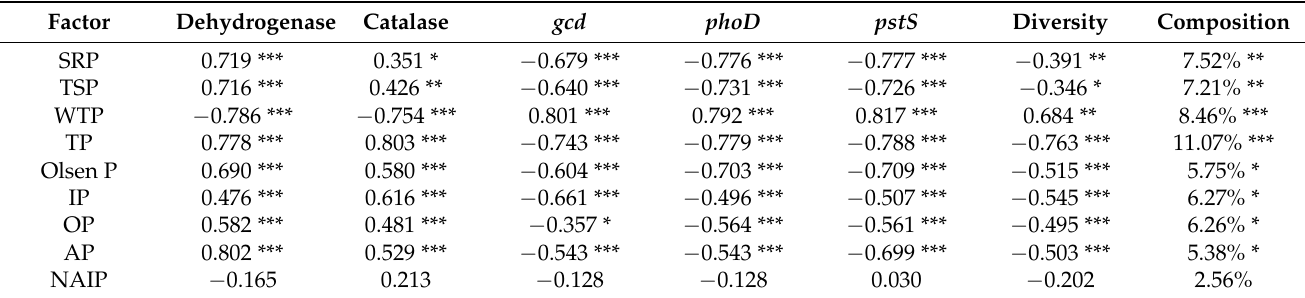
Figure 5. Differences in absolute abundances of phosphorus-cycling-related genes (i.e., gcd , phoD , and pstS ) among five TiO 2 NP addition amounts (i.e., A1, A2, A3, A4, and A5). Lowercase letters above the columns represent significance ( p < 0.05). Table 1. Pearson’s correlations between phosphorus fractions and dehydrogenase activity, catalase activity, and taxonomic diversity (Shannon–Wiener index), and the effects of phosphorus fractions on bacterial community composition based on PERMANOVA. Asterisks denote significance (*, p < 0.05; **, p < 0.01; ***, p < 0.001). Abbreviations of phosphorus fractions are defined in the “Materials and Methods”